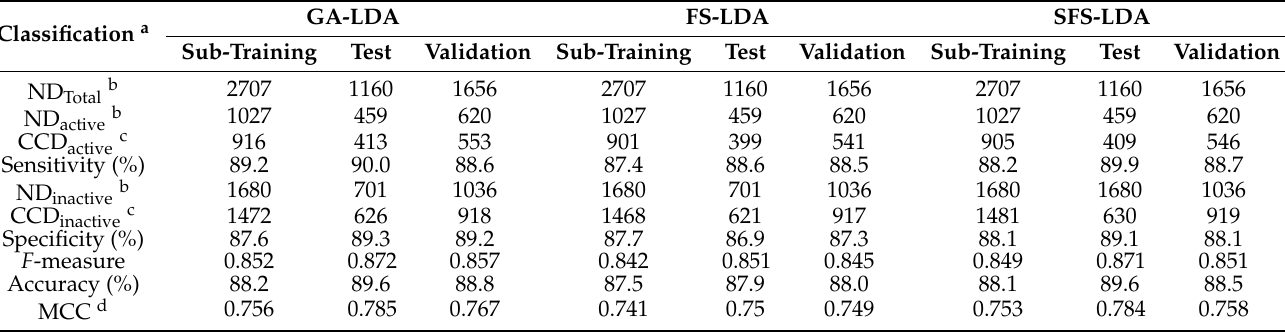
relation coefficient.